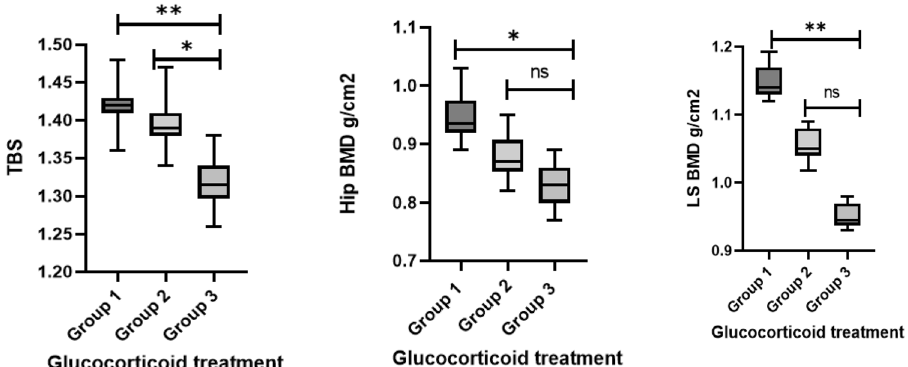
Figure 1. Differences between DXA parameters in the groups 1, 2, 3 according to glucocorticoids exposure, using general linear model adjusting for age, gender, disease duration, age at diagnosis. *p < 0.05, **p < 0.001, ns no significance.